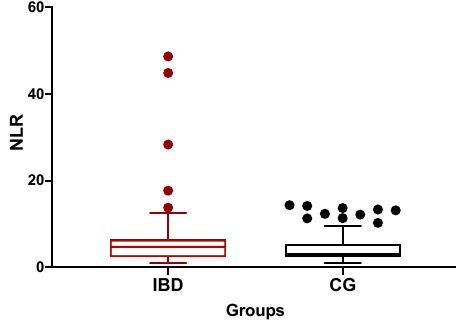
Figure 1. The median neutrophil-to-lymphocyte ratio (NLR) of inflammatory bowel disease (IBD) dogs